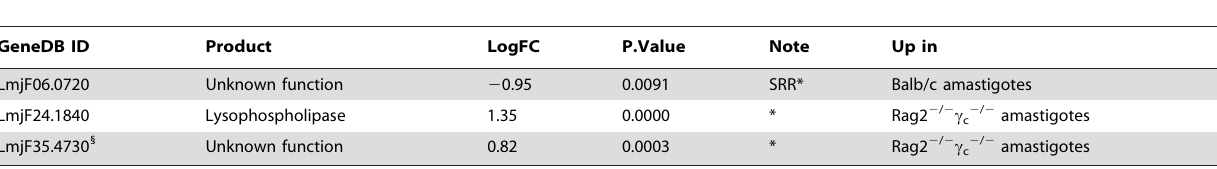
Table 4. Genes differentially expressed in L. major amastigotes from different host genetic backgrounds.